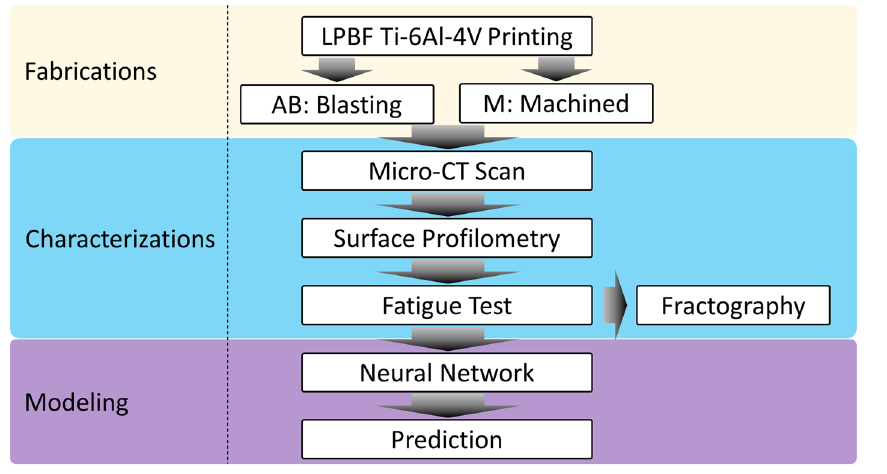
Figure 1. Scheme of this